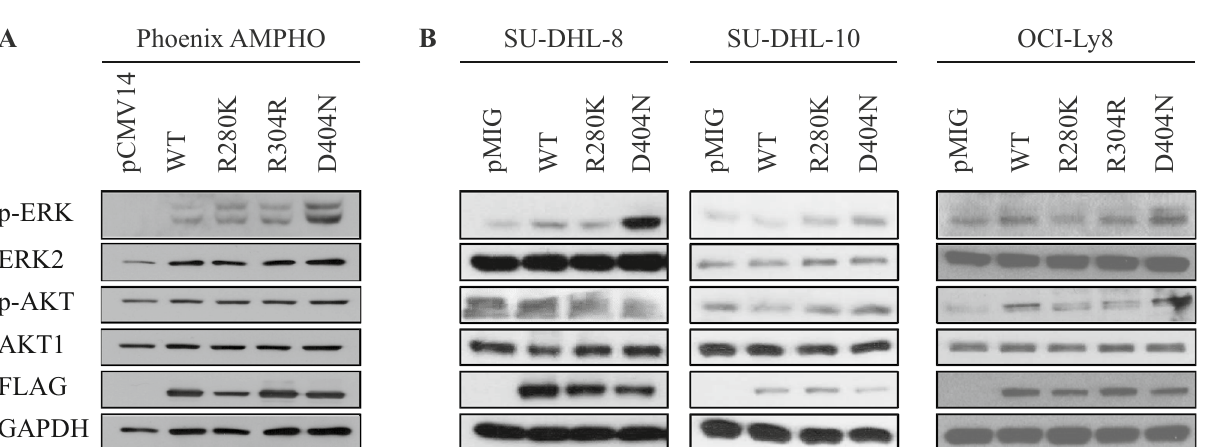
Figure 4. Mutant RASGRP4 D404N Phoenix AMPHO cells ( A ) and RASGRP4 D404N GCB-DLBCL ( B ) have a higher level of p-ERK than RASGRP4 WT cells in normal serum condition (10% FBS). AKT and p-AKT (Ser473) were not changed by mutational